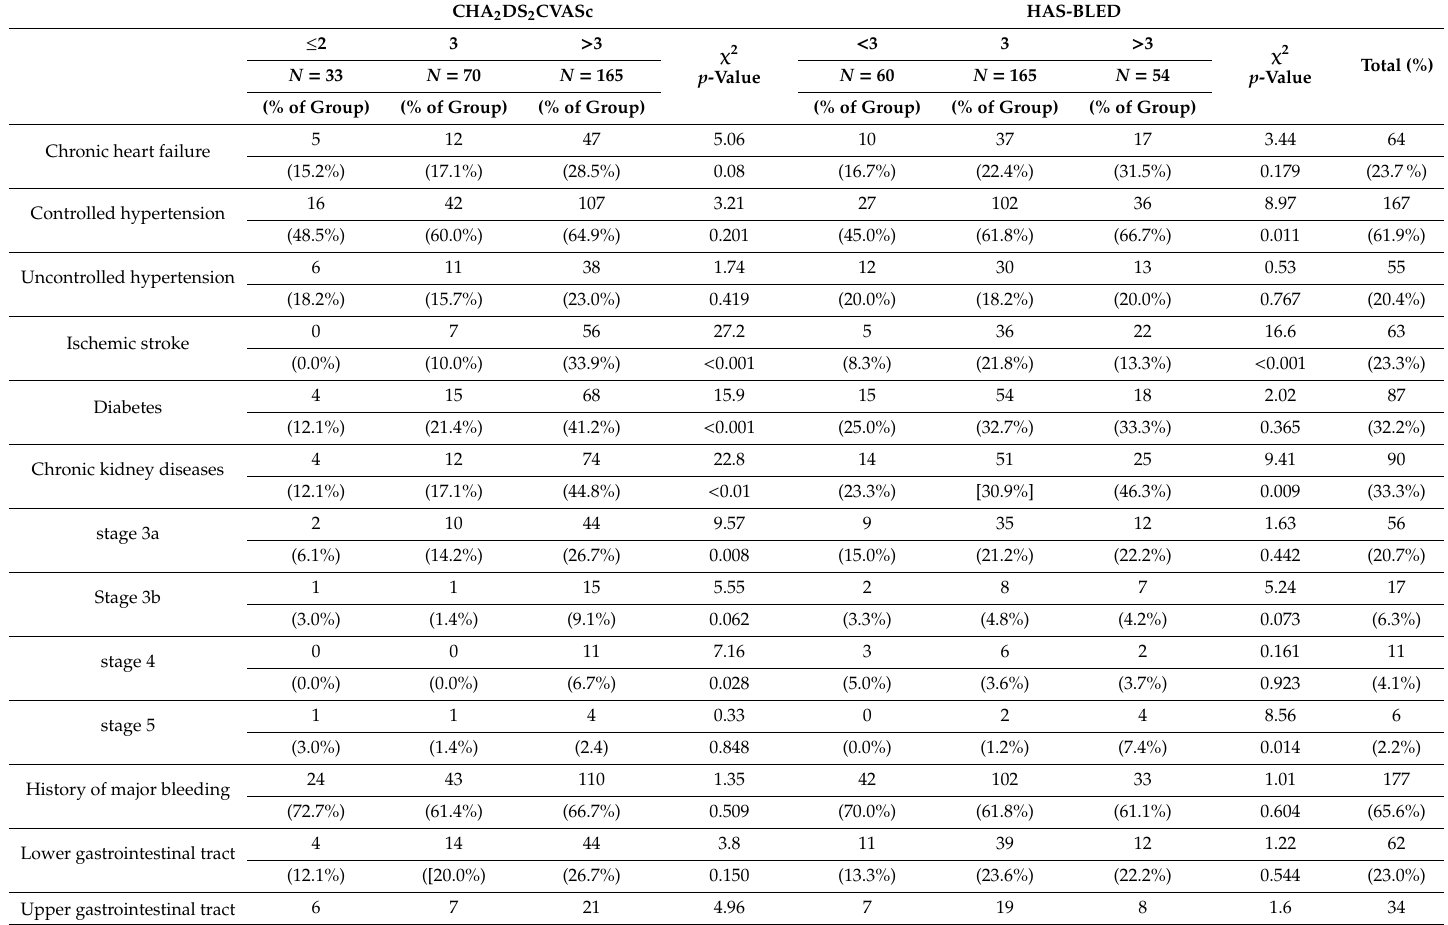
Table 1. Comorbidities in the study